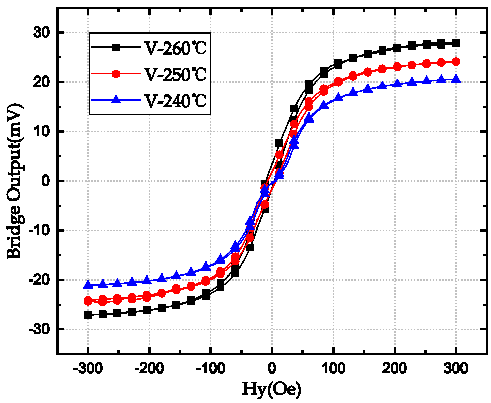
Figure 6. The outputs in the y -axis for the full Wheatstone-bridge-based GMR sensors annealed at different temperatures.